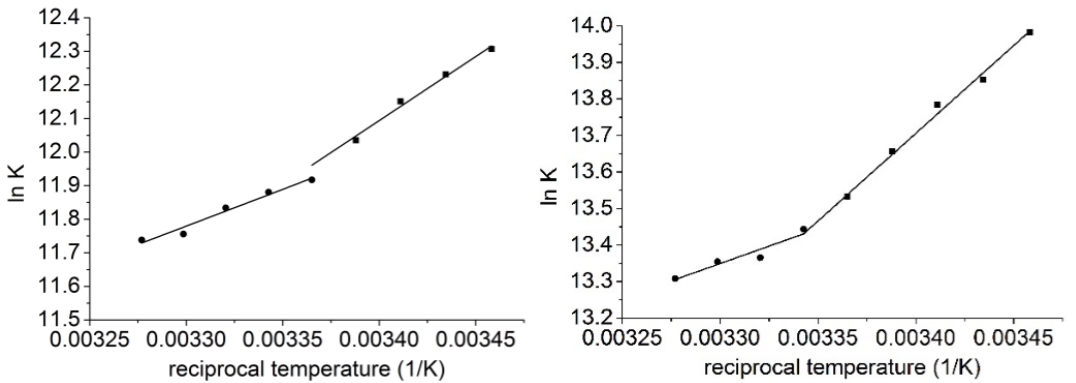
Figure 3. van’t Hoff plot to determine the thermodynamic parameters associated to the formation of 1 – 6 complexes in methanol (left) and in dimethylformamide (right) solvents. 1 – 6 complexes in methanol (left) and in dimethylformamide (right) solvents. Table 1. Complex stability constants (log K values) associated to the complex formation of 1 with 6 in Table 1. Thermodynamic parameters associated to the complex formation of 1 with 6 in methanol or methanol or the DMF solvent determined for di ff erent the DMF solvent.